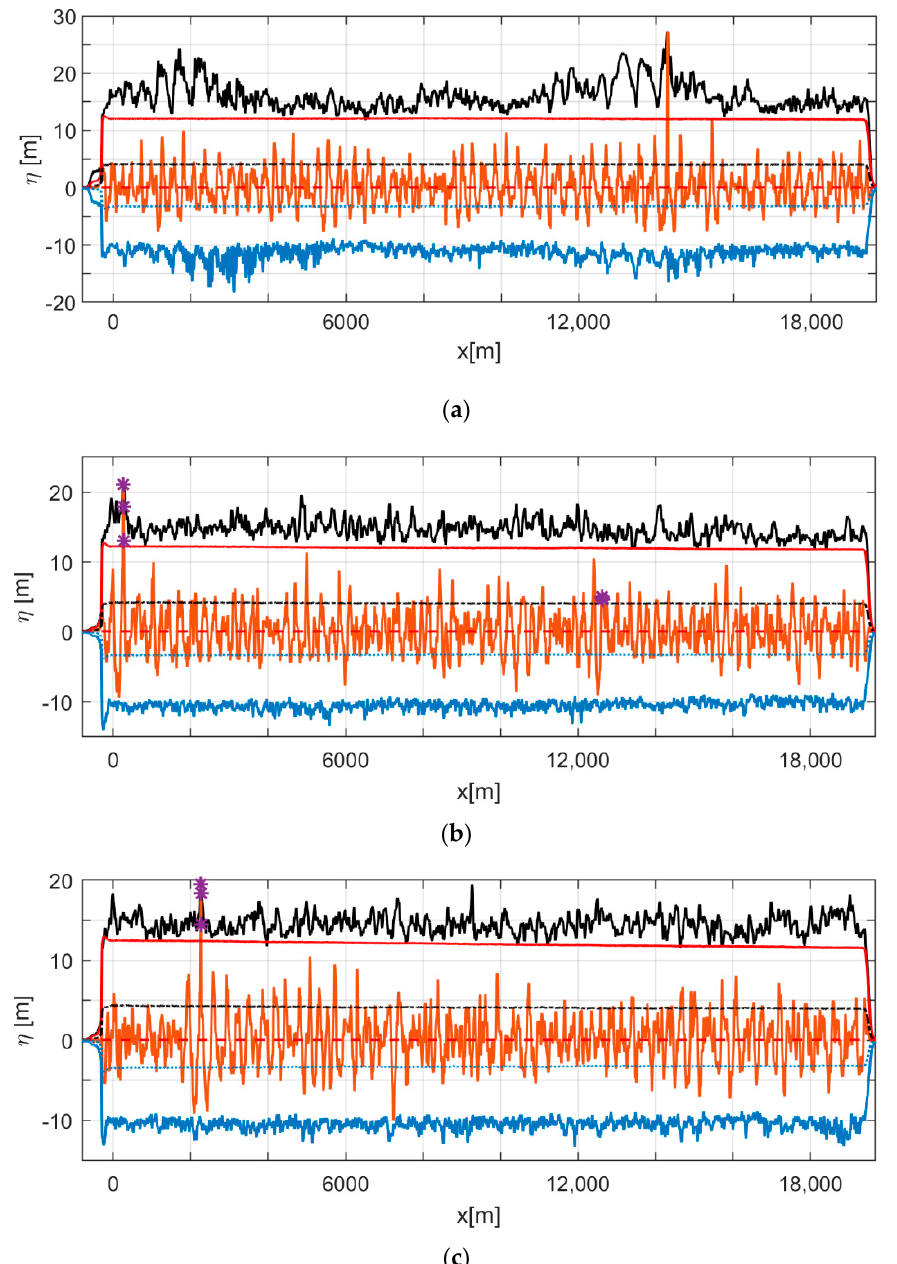
Figure 18. From top-down, the wave-prints of the 1D long-crested Draupner simulations without breaking in ( a ), with U/C = 0.9 in ( b ) and U/C = 0.8 in ( c ), respectively. The wave profile as shown is at the instant that the most extreme wave occurs; for the nonbreaking simulation on top, this highest wave is the second of a quadruple freak wave event. The lines in the wave-print plot are the MTC (solid black), Hs (solid red), ATC (dash-dot black), MWL (dash-red), ATT (dotted blue), MTT (solid blue), breaking events (purple star), and snapshot when the highest wave occurred (solid orange). In the 1D long-crested simulation, without breaking, an extreme event of four suc- cessive freak wave heights took place, caused by three successive waves. All four crest heights are greater than 1.6 Hs, namely, (referring to Figure 19) 22.21 m (blue dash-dot), 27.26 m (red solid), 20.2 m (yellow dash), 20.24 m (purple dot), with time intervals of 46, 33, and 12 s, successively; the third and fourth crests are from the same propagating wave. Parts of the profiles are shown in Figure 19. It is notable that the steepness of the